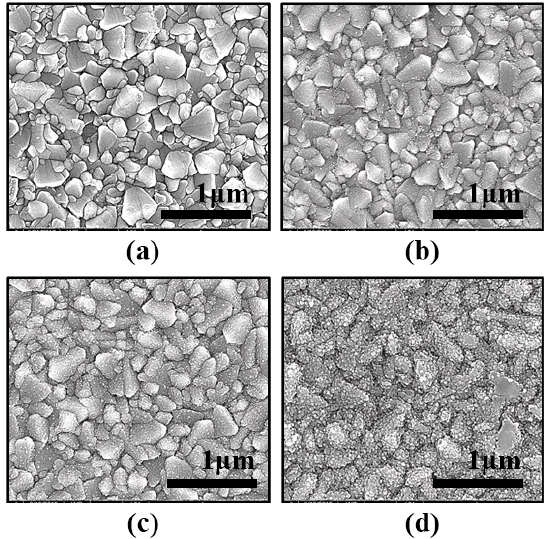
Figure 3. SEM images of FTO glass pre-treatment by different concentrations of TiCl 4(aq) : ( a ) 0